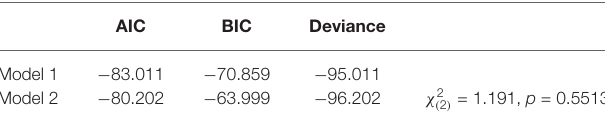
TABLE 1 | Fit indices for Models 1 and 2 .